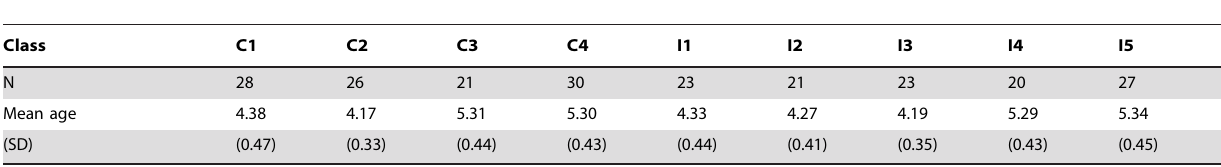
Table 1. Class profiles of number and mean